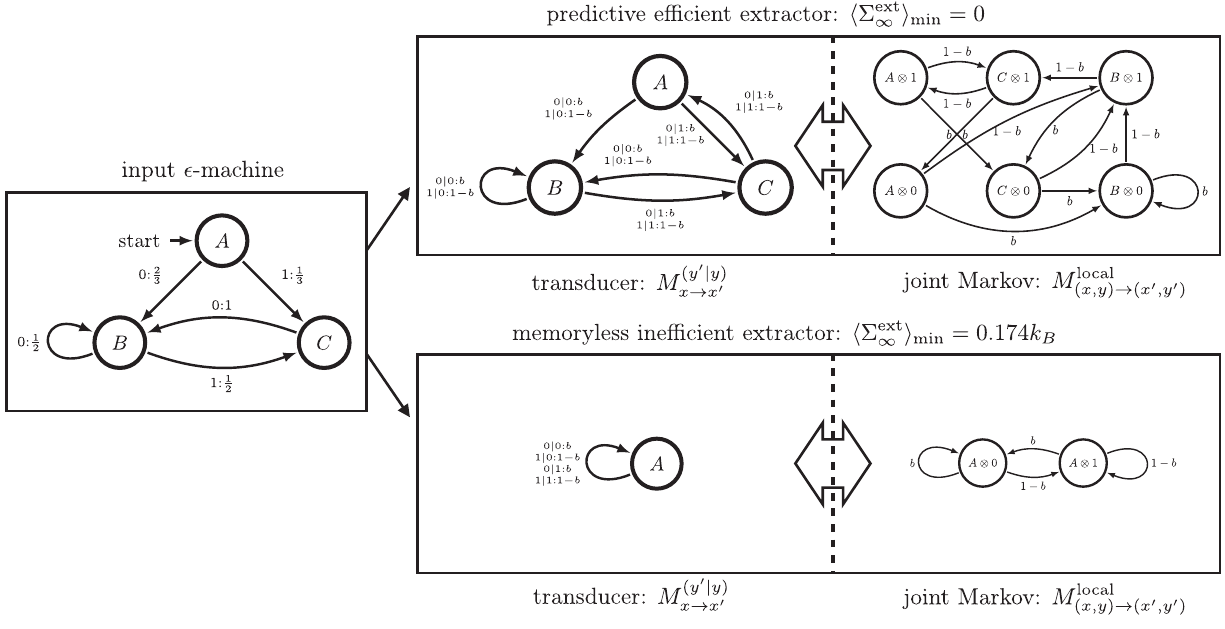
FIG. 4. Multiple ways to transform the golden mean process input, whose ϵ -machine generator is shown in the far left box, into a sequence of uncorrelated symbols. The ϵ -machine is a Mealy hidden Markov model that produces outputs along the edges, with y ∶ p denoting that the edge emits symbol y and is taken with probability p . Top row: Ratchet whose internal states match the ϵ -machine states and so it is able to minimize dissipation ( h Σ ext ∞ i ¼ 0 ) by making transitions such that the ratchet ’ s states are synchronized to min the ϵ -machine ’ s states. The transducer representation to the left shows how the states remain synchronized: Its edges are labeled y 0 j y ∶ p , which means that, if the input is y , then the edge is taken with probability p and outputs y 0 . The joint Markov representation on the right depicts the corresponding physical dynamic over the joint state space of the ratchet and the interaction symbol. The label p along an edge from the state x ⊗ y to x 0 ⊗ y 0 specifies the probability of transitioning between those states according to the local Markov channel M local ¼ p . Bottom row: In contrast to the efficient predictive ratchet, the memoryless ratchet shown is ð x;y Þ → ð x 0 ;y 0 Þ inefficient, since its memory cannot store the predictive information within the input ϵ -machine, much less synchronize to